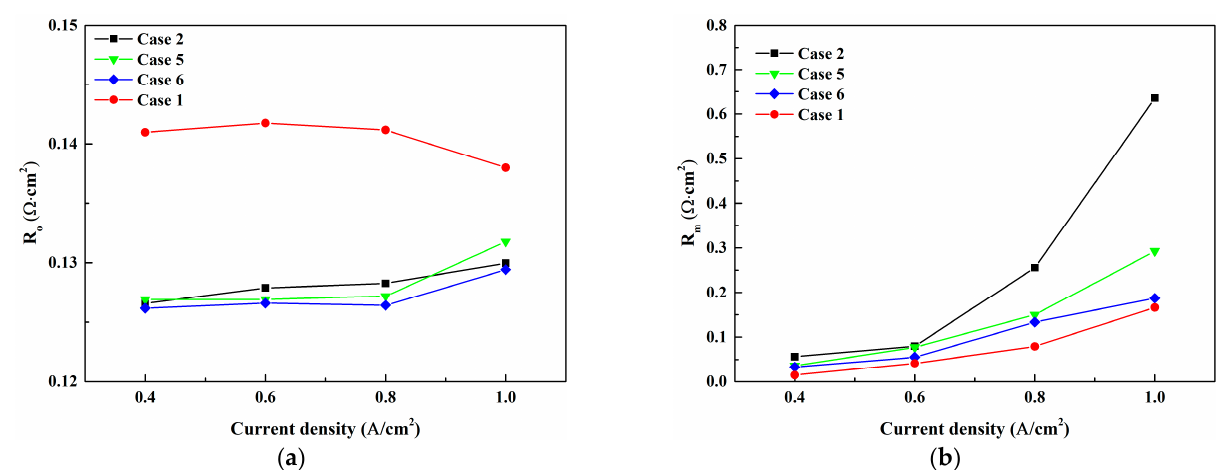
Figure 8. ( a ) Ohmic resistance and ( b ) mass transfer resistance as a function of current density in various RHc cases.